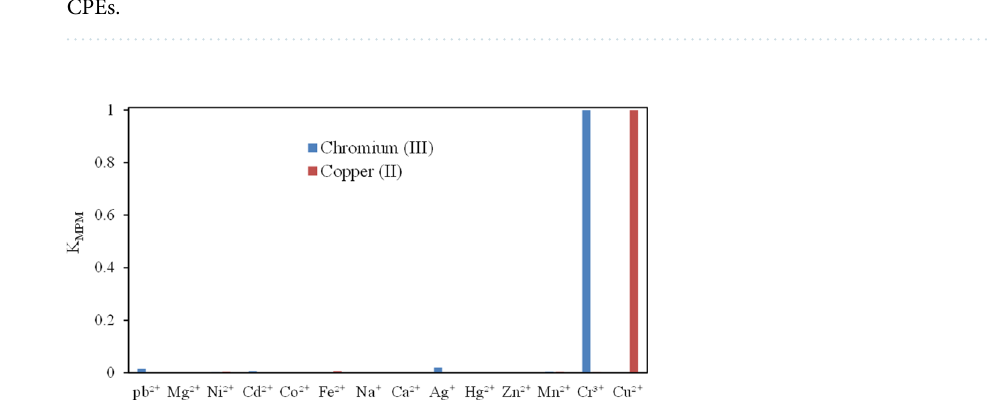
Figure 4. The values of K MPM of proposed CPEs for a variety of different cations; red bars represent K MPM of copper (II) selective electrode, and blue bars represent K MPM chromium (III) selective electrode.